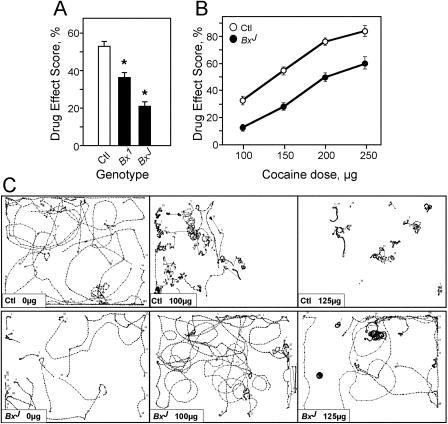

Lmo Gain-of-Function Bx Alleles Show Reduced Sensitivity to Cocaine(A) Cocaine phenotypes of Bx mutants. Male flies hemizygous for Bx alleles Bx1 or BxJ show significant reductions in sensitivity to cocaine compared to control (Ctl) flies (p < 0.001, n = 12 experiments). Asterisks denote significant differences from control (Student's paired t-test assuming equal variance).(B) Dose–response. BxJ flies (filled circles) show reduced sensitivity compared to Ctl flies (open circles) at all doses tested (p < 0.001, n = 16–20 for all doses except for 250 μg, where p = 0.0015, n = 8). Two additional Bx alleles (Bx2 and Bx3) had similar phenotypes to Bx1 (not shown).(C) BxJ flies show alterations in cocaine-induced locomotor patterns of activity. Flies were exposed to 0, 100, or 125 μg of cocaine, as indicated, for 1 min. Representative traces shown are 30 s of recorded activity of about ten flies starting 30 or 60 s after the end of cocaine exposure (n ≥ 3). Top panels show response of control flies to indicated amounts of cocaine; bottom panels show activity of BxJ flies after cocaine administration. Ctl flies are w1118.